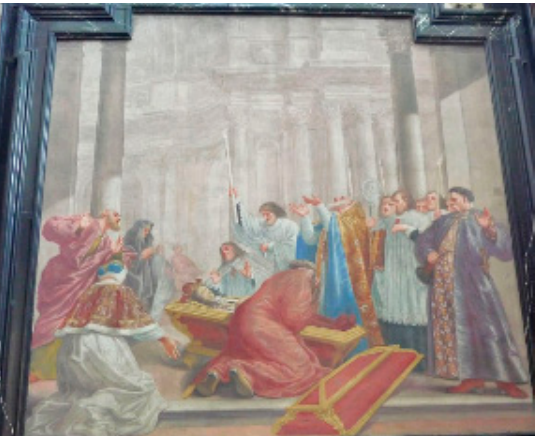
Figure 4. Michelangelo Palloni, Translatio and revelation of Kazimierz’s miraculously preserved body, 1690s. Vilnius Cathedral, Lithuania. Photo by the